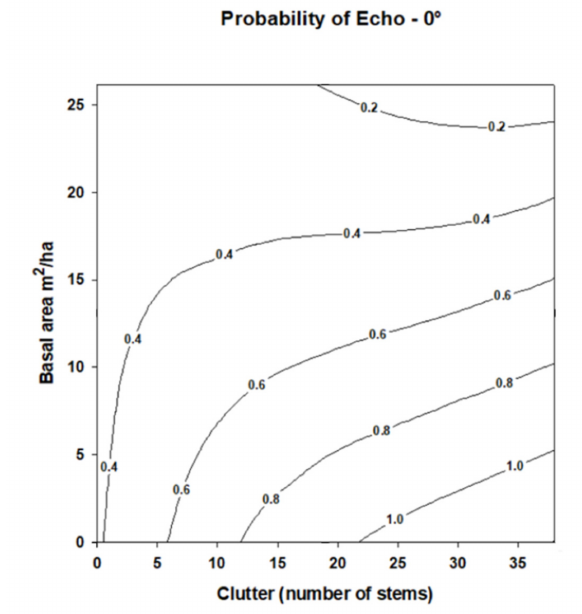
Figure 6. Contour graph for generalized linear model results of synthetic bat echolocation playback response within an anechoic chamber displaying the probability of receiving an echo pulse in relation to stem density (stem count) and basal area (m 2 /ha) for the 0 ◦ detector angle. All other angles had a probability of 0 for all conditions (see text for details), Blacksburg, VA, USA,